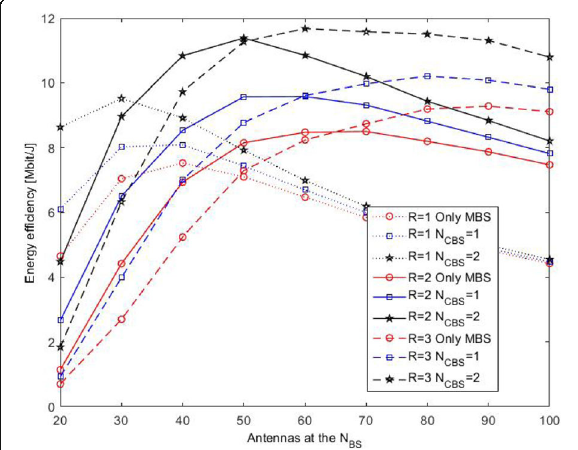
Fig. 9 EE with respect to N BS for different coordination schemes N CBS ∈ {0, 1, 2}, R ∈ {1, 2, 3}, and N S = 2. ------ represents the achievable rate constraints of 3 bit/s/Hz. — represents the achievable rate constraints of 2 bit/s/Hz. …… represents the achievable rate constraints of 1 bit/s/Hz. о represents there is only macro base station and the number of small base station N CBS = 0 . □ represents the number of small base station N CBS = 1 . ☆ represents the number of small base station N CBS = 2